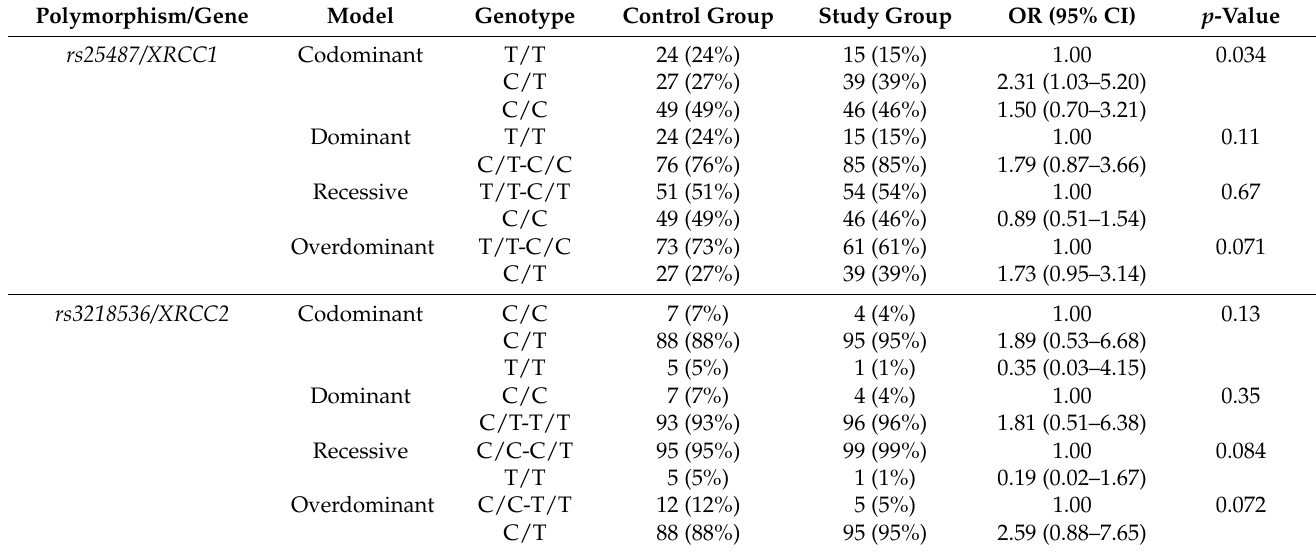
Table 4. Correlation of RA with the frequency of genotypes of the DDR